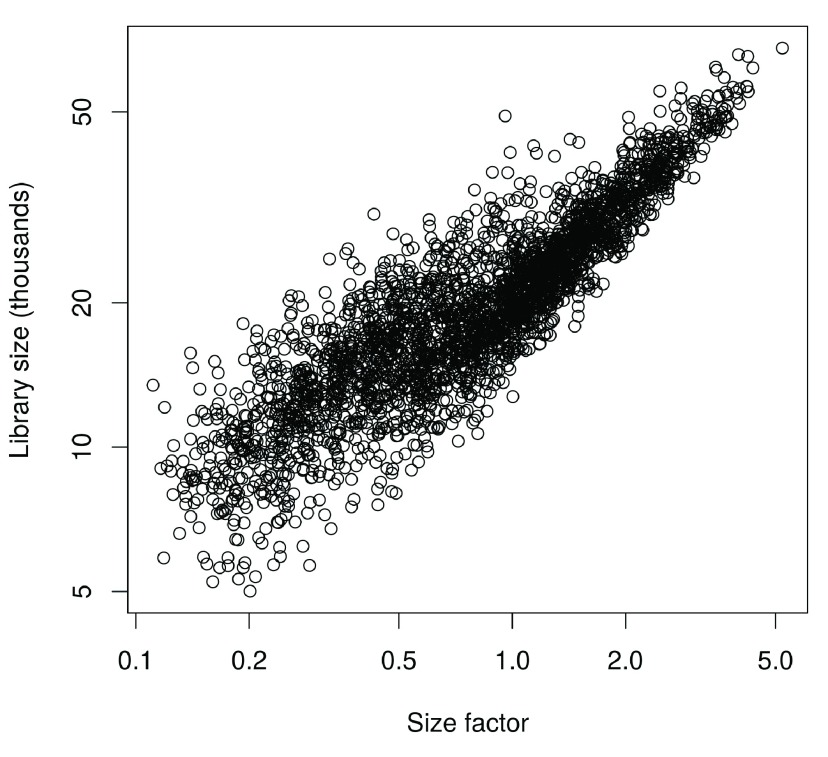
Size factors from deconvolution, plotted against library sizes for all cells in the brain dataset.Axes are shown on a log-scale.